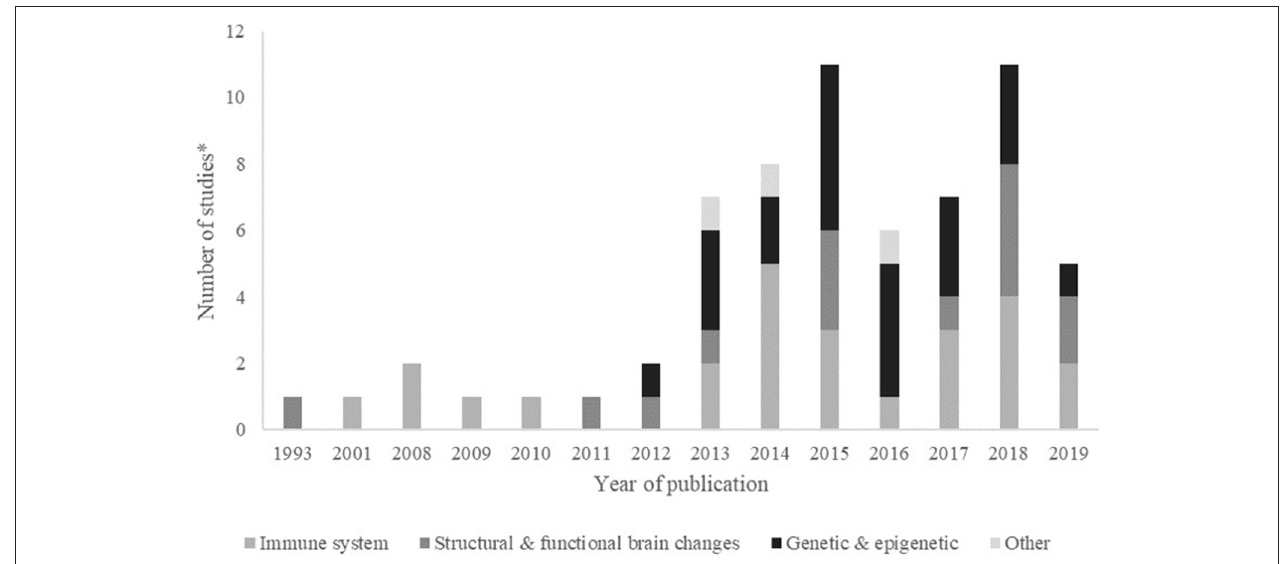
FIGURE 2 | Frequency (number of studies*) by biological mechanism, published per year. *Some papers evaluated more than one biomarker, within or not the same biological mechanism. Year 2019 includes papers published online until July